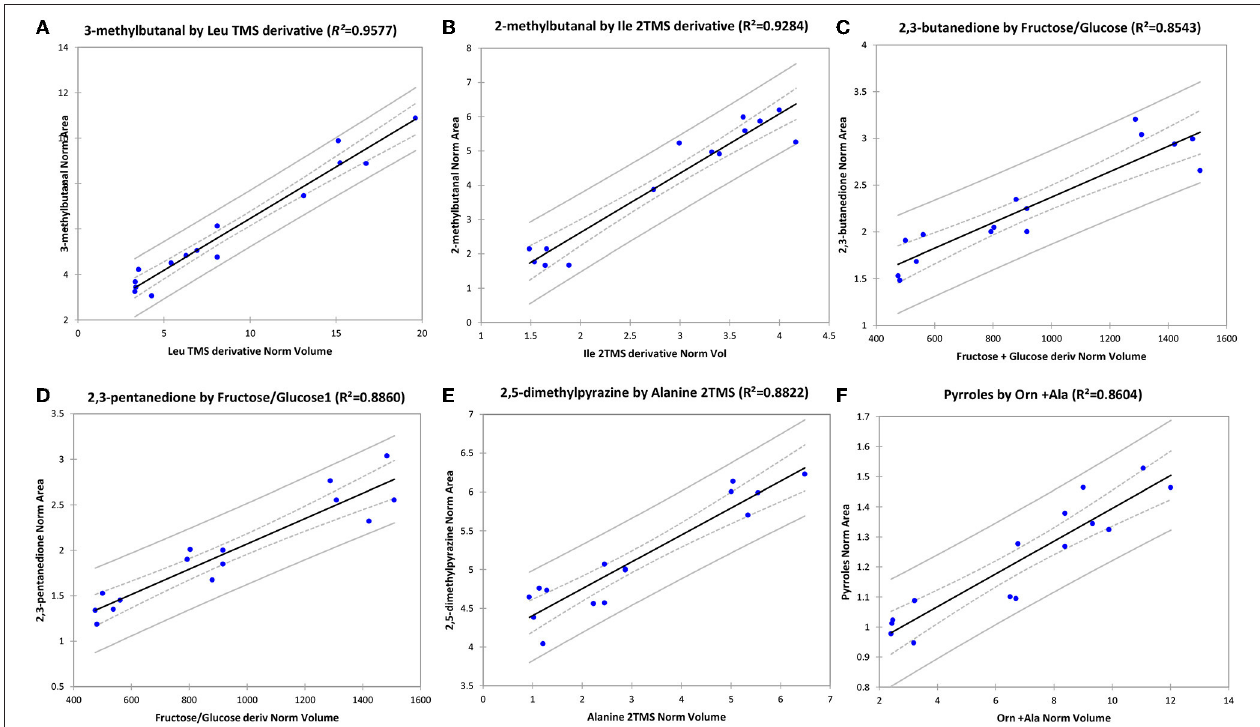
FIGURE 4 | Linear regression functions (confidence interval 95%) between primary metabolites and/or precursors with corresponding key-odorants in roasted kernels. (A) 3-Methylbutanal with Leucine (R 2 0.9577), (B) 2-Methylbutanal and Isoleucine (R 2 0.9284), (C) 2,3-Butanedione and (D) 2,3-Pentanedione and the sum of fructose ( syn - and anti - forms) and glucose (glucopyranose and glucose) (R 2 0.8543 and 0.8860), (E) 2,5-Dimethylpyrazine and Alanine (R 2 0.8822), and (F) pyrroles and the sum of Ornithine and Alanine (R 2 0.8604) (from Cialiè Rosso et al.,